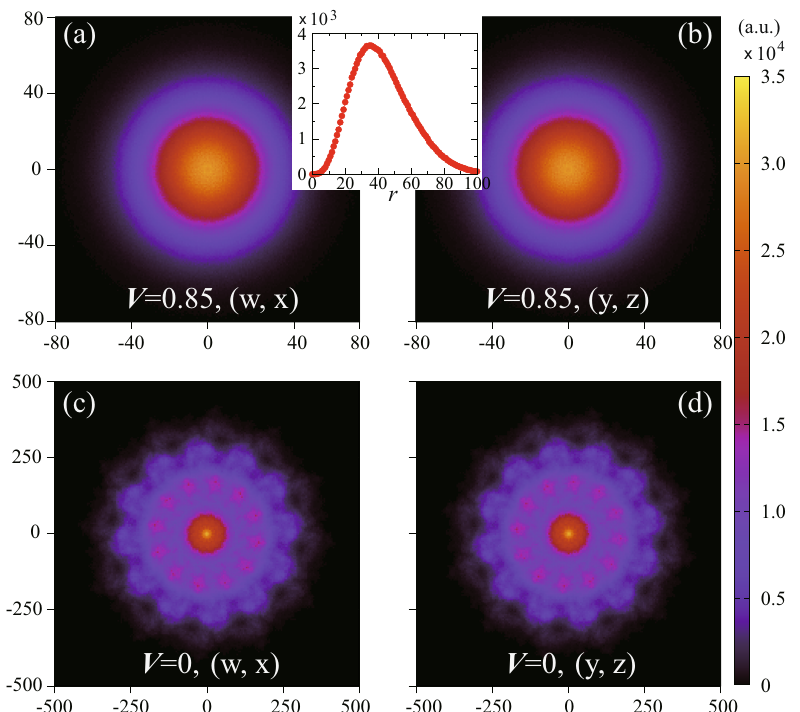
Fig. 3 The four-dimensional order parameter. a and b are the projection of the four-dimensional order parameter ( w , x , y , z ) at the QSL-VBS critical point with V = 0.85 on the two-dimensional ( w , x ) plane ( a ) and on the ( y , z ) plane ( b ). (Inset) The density distribution per unit sphere area of the O(4) order parameter modulus at V = 0.85, such radial dependence reveals that the order parameter indeed form a O(4) sphere. The red line joins the points. c and d are the projection of the four-dimensional order parameter deep in the The histogram is on the ( w , x ) plane ( c ) and the ( y , z ) plane ( d ). The data in a , b , c and d are obtained from system size L = β = 36( T =